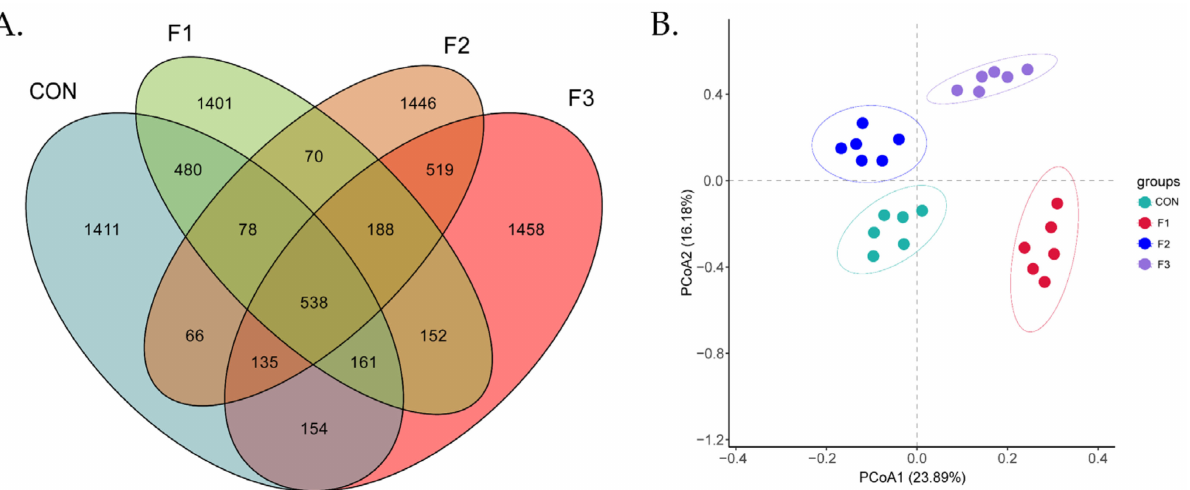
Figure 5. Diversity analysis. ( A ) Venn diagrams of OTUs sharing >97% nucleotide sequence identity; ( B ) principal co-ordinates (PCoA) analysis of OUTs; CON, basal diet; F1, basal diet + 0.1% fucoidan; F2, basal diet + 0.3% fucoidan; F3, basal diet + 0.5% fucoidan; OTUs, operational taxonomic units; PCA, principal component analysis.